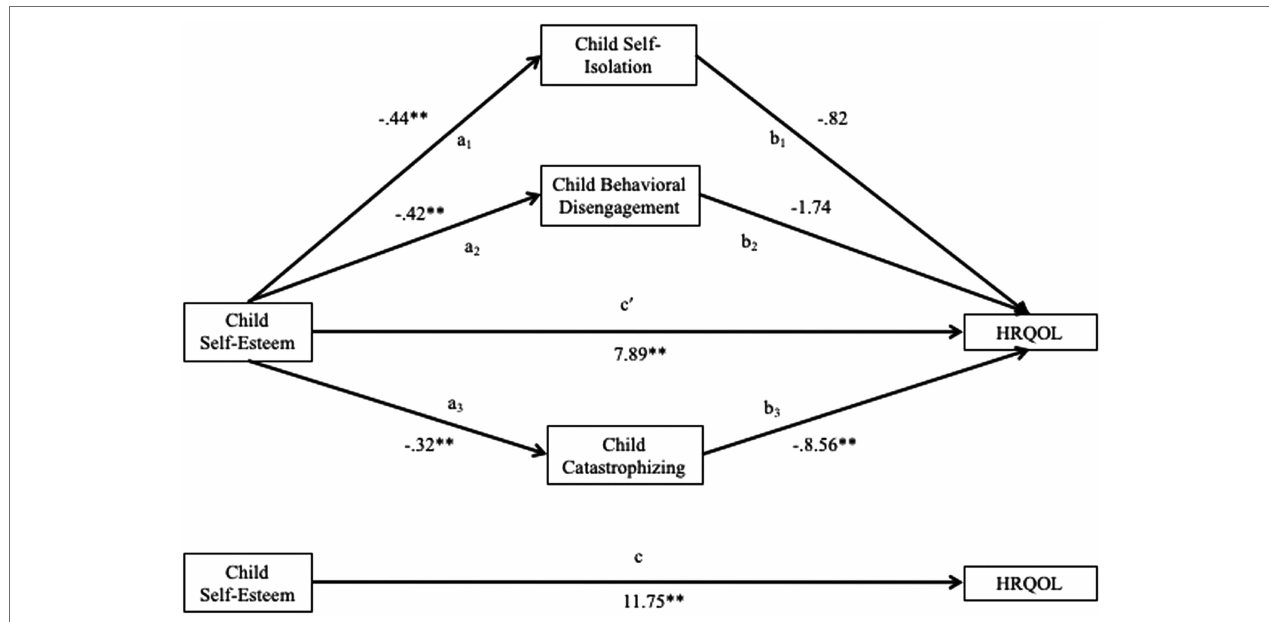
FIGURE 1 | Multiple meditation model of HRQOL. a 3 b 3 , significant indirect effect. Disease activity, child age, and child gender included as covariates. * p < 0.05, ** p <